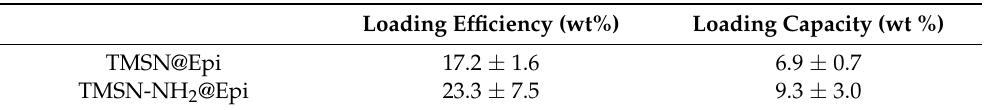
Table 2. Drug loading efficiency and loading capacity of TMSN@Epi and TMSN-NH 2 @Epi (data are presented as means ±